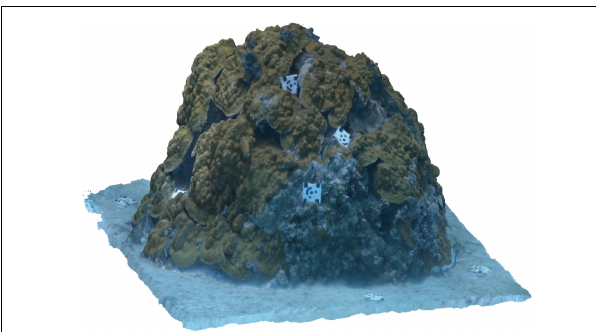
FIGURE 2 | A textured mesh representing the example coral patch—which is roughly 1.5 m in diameter and 3 m in height—was reconstructed from still images extracted from video footage using Agisoft Metashape SfM photogrammetry software. The mesh consisted of 10 million faces and had an estimated accumulative error of 1.4 mm after providing absolute scale using the actual dimensions of the coded